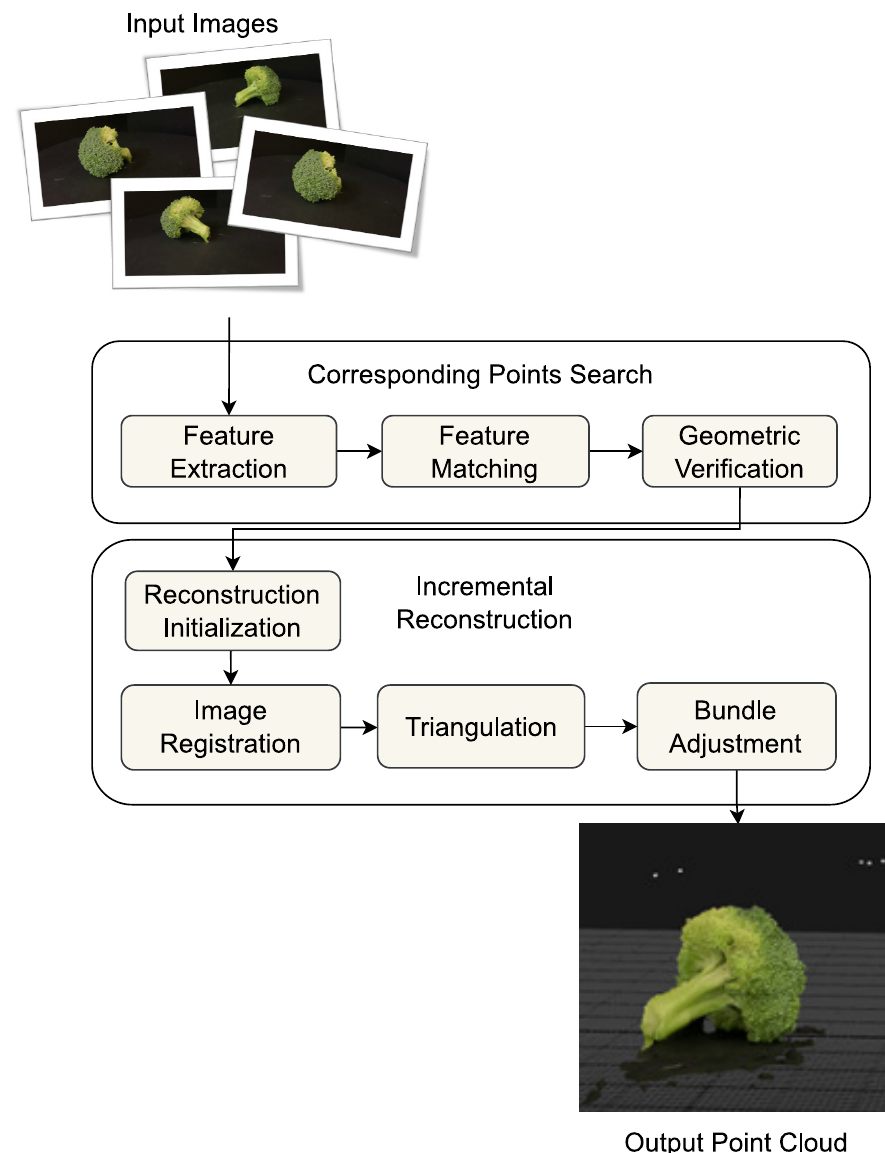
Figure 3. Incremental Structure from Motion